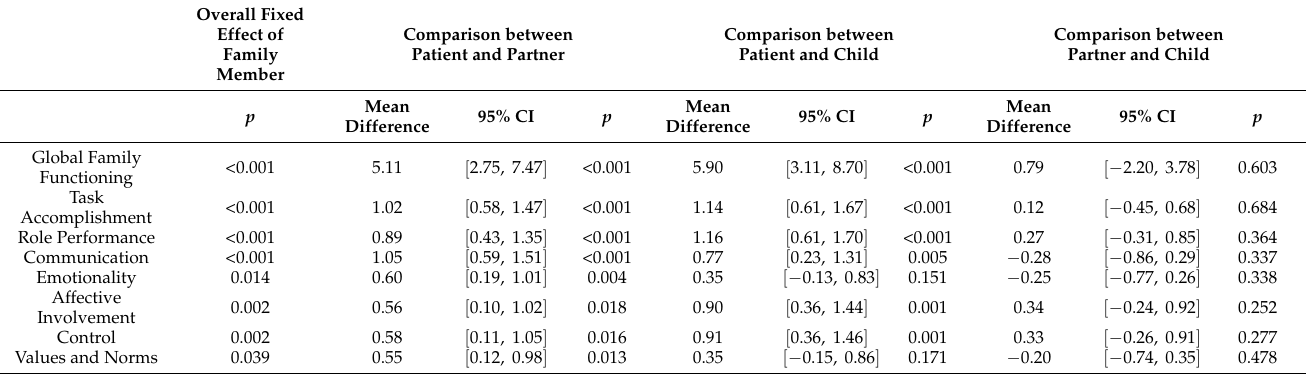
Table 4. Differences between family members’ ratings of family